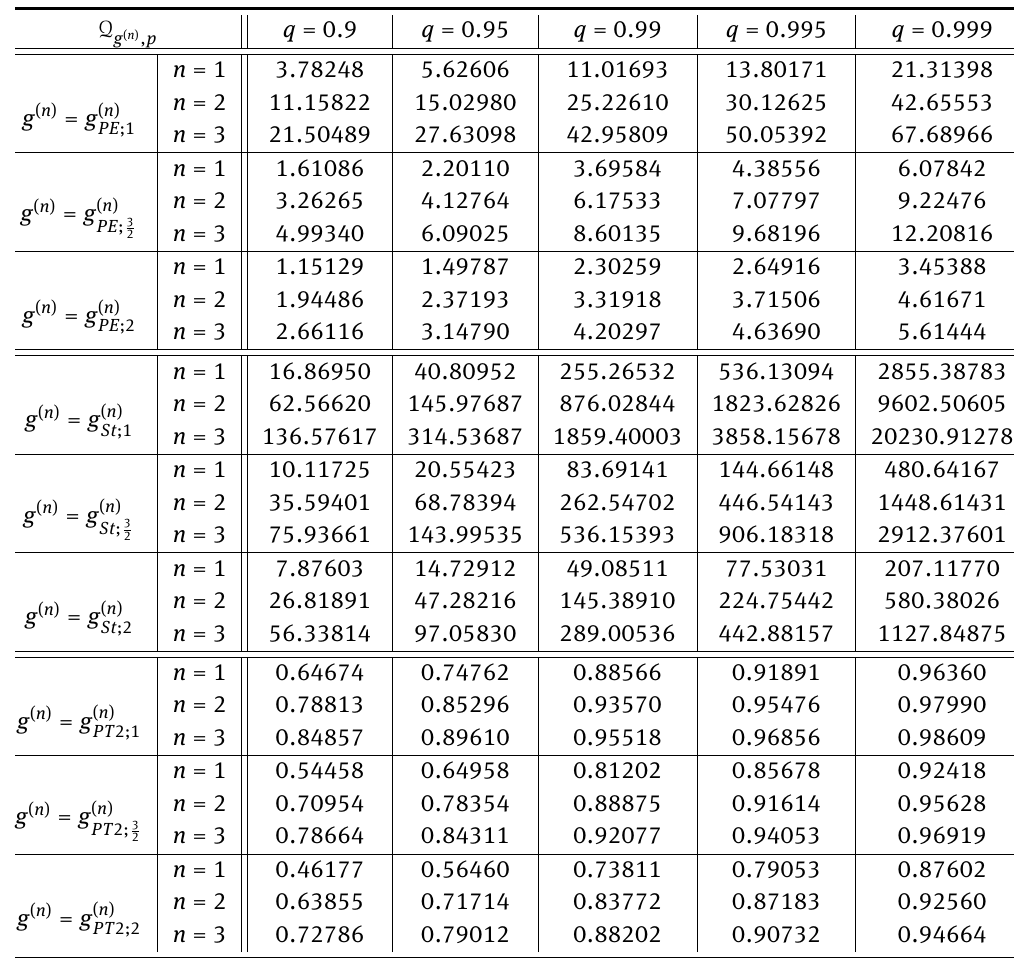
w.r.t. B n , p are computed for q ∈ { 0.9, 0.95, 0.99, 0.995, 0.999 } , p = 1 2 and for several